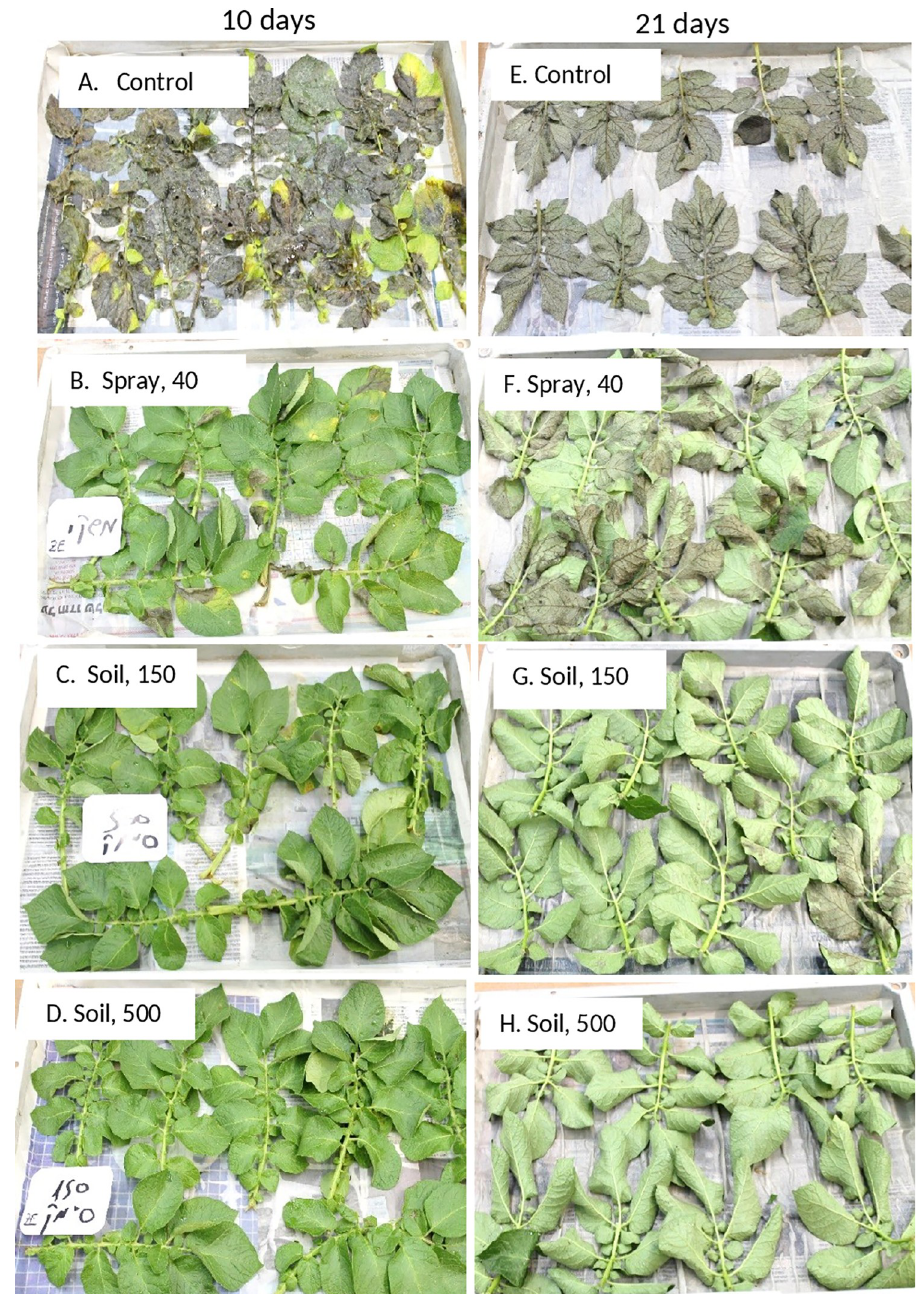
a soil drench of 150 or 500 g ai/ha. Leaves were detached at 10 and 21 days after treatment and inoculated with sporangial suspension of the pathogen in growth chambers at 20˚C. Photos was taken at 7